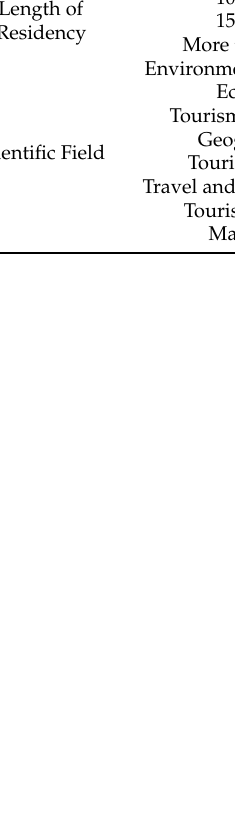
Table 6. Evaluation of ecotourism sustainability levels in the studied